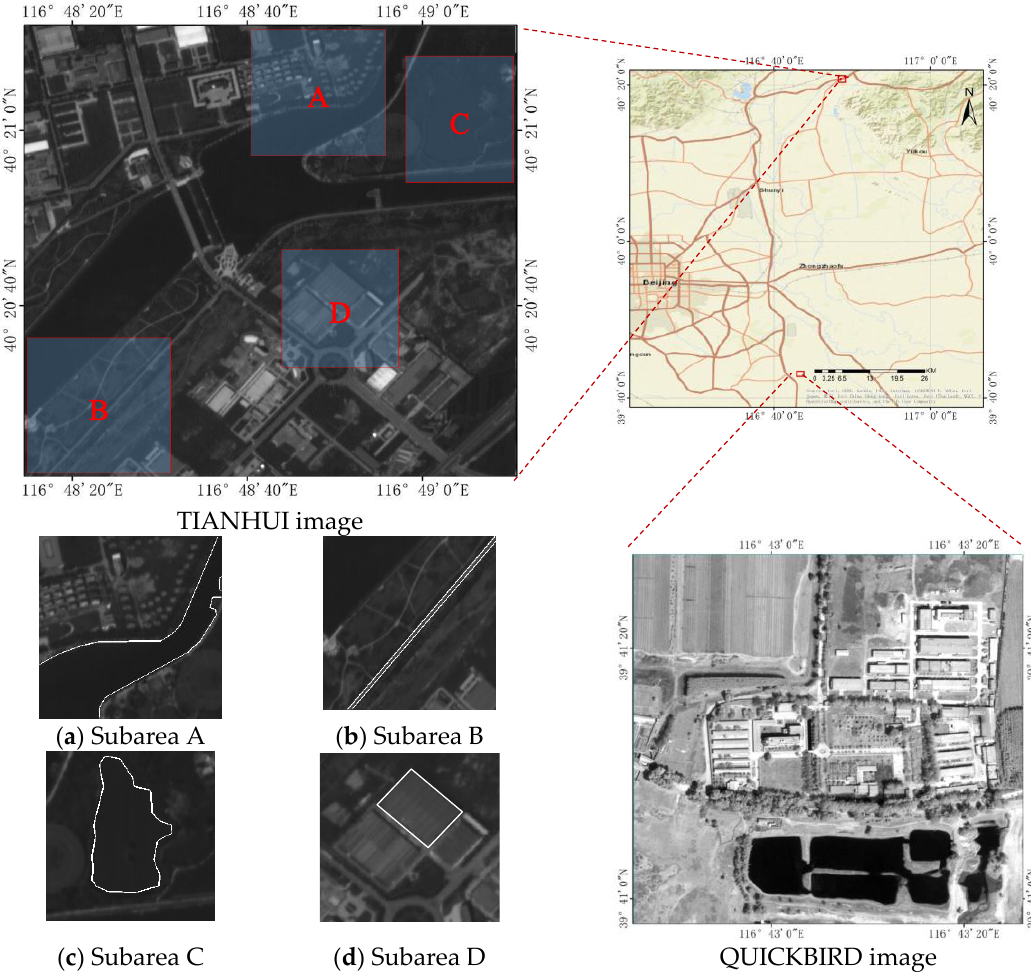
Figure 6. Two VHR satellite images used in our experiments, where subfigures ( a – d ) show the subarea A, B, C, and D coupled with boundaries of interested geo-objects, respectively.